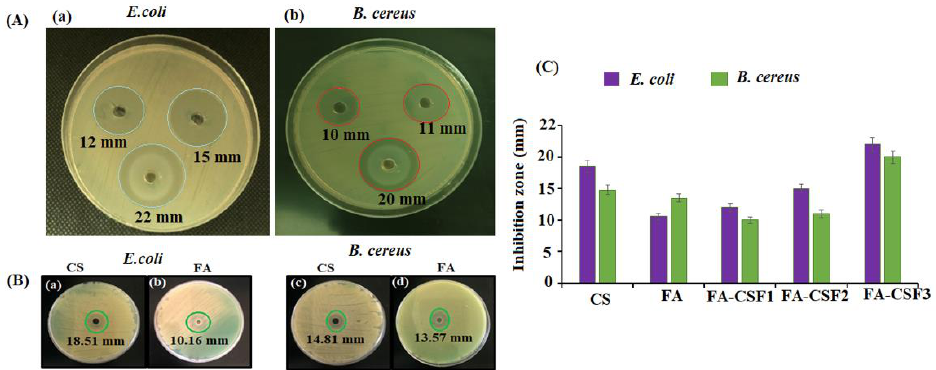
Figure 6. ( A - a , b ) the inhibition zones displayed by FA-CSF1, FA-CSF2, and FA-CSF3 films on E. coli and B. cereus , respectively. ( B - a , b ) Inhibition zone diameter of 1% CS and 1% FA solutions against E. coli and ( B - c , d ) against B. cereus, respectively. ( C ) Zone of inhibition diameter/mm, Data were presented in average mean ± SD ( n ≥ 3).